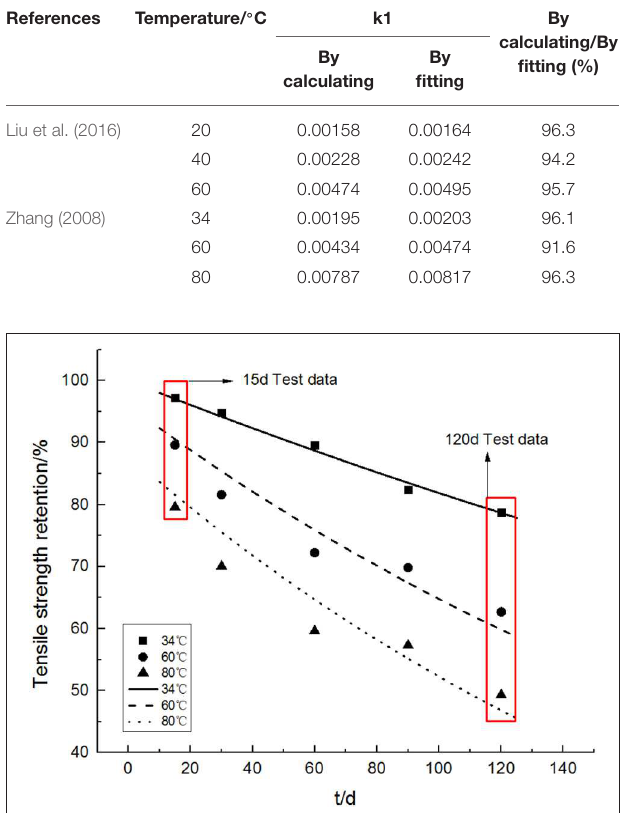
FIGURE 8 | Comparisons between test data and calculated curves.